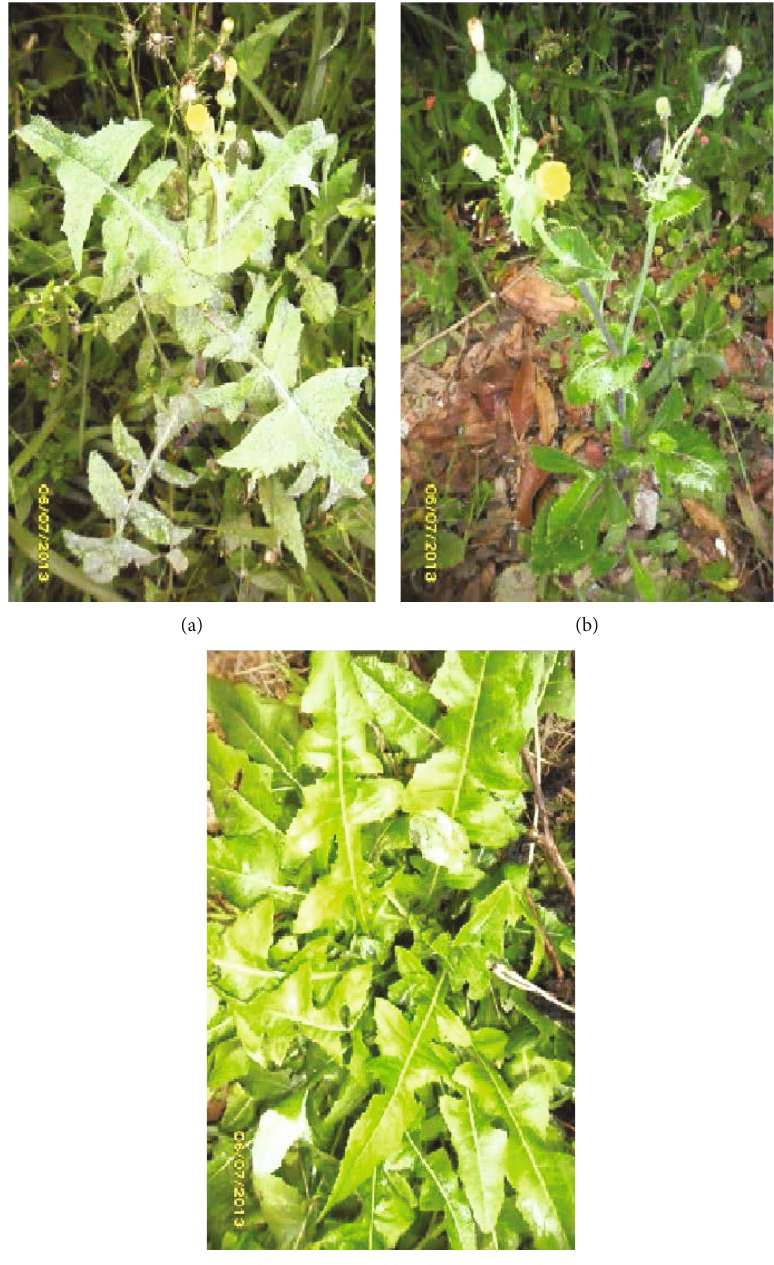
Figure 1: S . oleraceus (a), S. asper (b), and S. arvensis